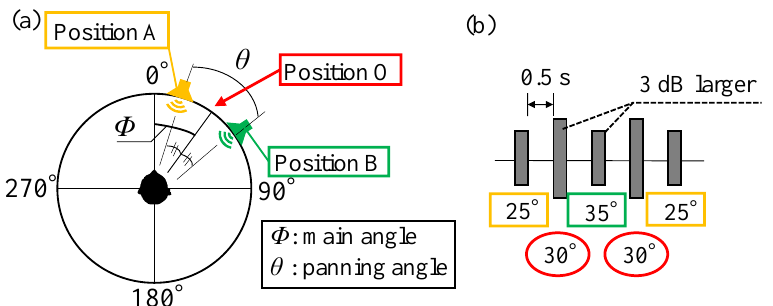
Figure 4. Overview of the sound reproduction method. ( a ) Procedure for generating panned sounds and ( b ) example of reproduction sound.